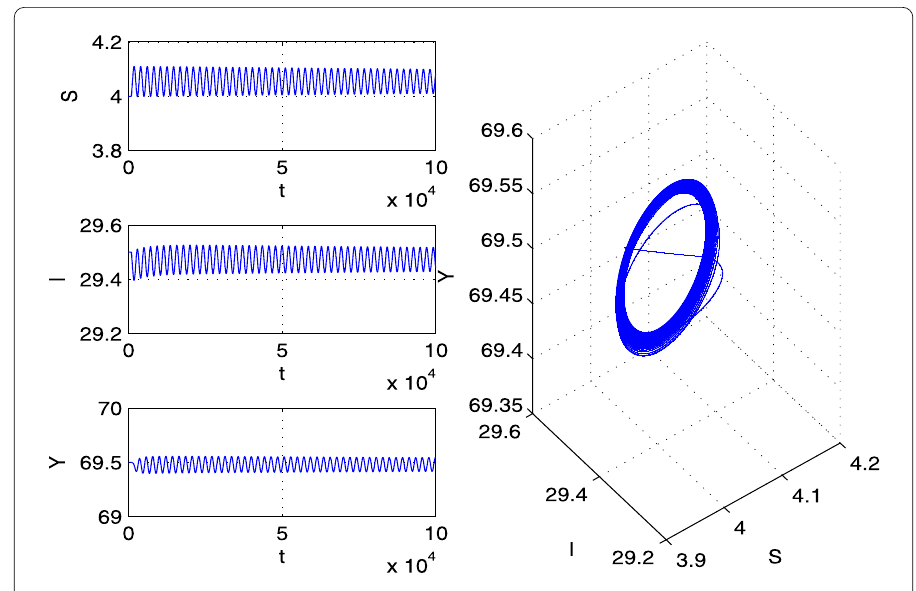
Figure 5 The trajectories of system (4.1) with τ 1 = 5.79, τ 2 = 5.2 > τ ∗ 20 = 4.5647. A Hopf bifurcation occurs from the positive equilibrium E . The initial value is